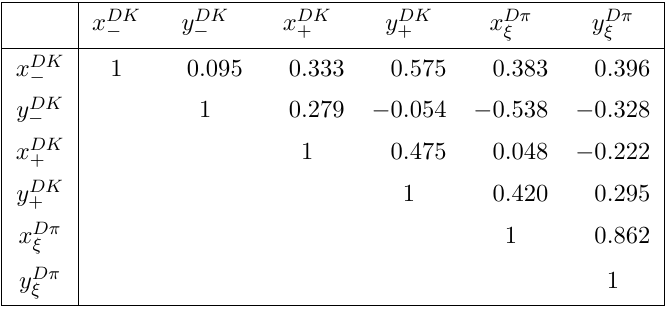
Table 8 . External inputs c i , s i systematics correlation matrix obtained for the Belle standalone data